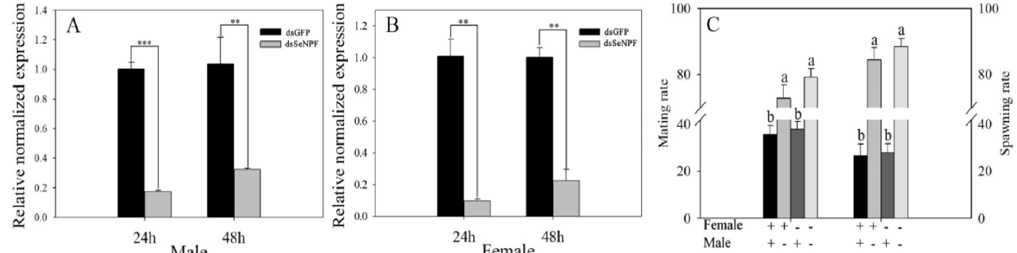
Figure 7. The effect of SeNPF on the mating and spawning rate in the SE-Sel strains. ( A ) The relative normalized expression of SeNPF of male adult after RNAi, (** means p < 0.01, *** means p < 0.001); ( B ) The relative normalized expression of SeNPF of female adult after RNAi, (** means p < 0.01); ( C ) The mating and spawning rate between different cross combinations (+ represents dsGFP, − represents dsSeNPF; e.g., the dark black (Female ‘+’, Male ‘+’) means that male injected with dsGFP and female injected with dsGFP are paired). Different numbers of asterisks indicate significant differences at different levels.